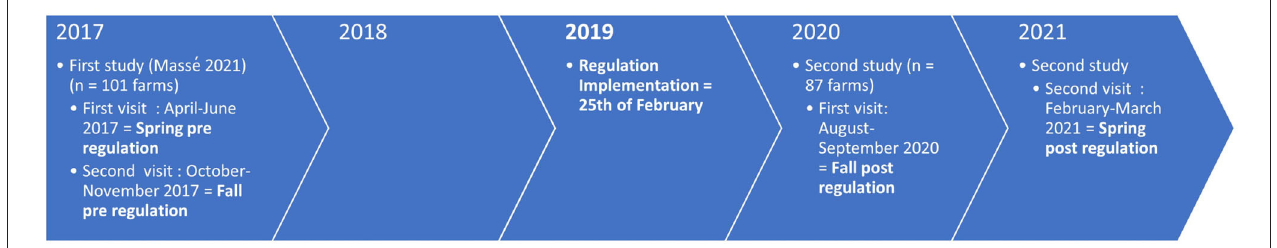
FIGURE 1 | Timeline of the sampling compared to the regulation implementation. Spring pre regulation and fall pre regulation were part of a previous study [Massé et al. (9)] that aimed at establishing the portrait of AMR in dairy farms in Québec, Canada. Spring post regulation and fall post regulation are the period of sampling ∼ 2 years after the implementation of the regulation in 87 of the same herds and used for